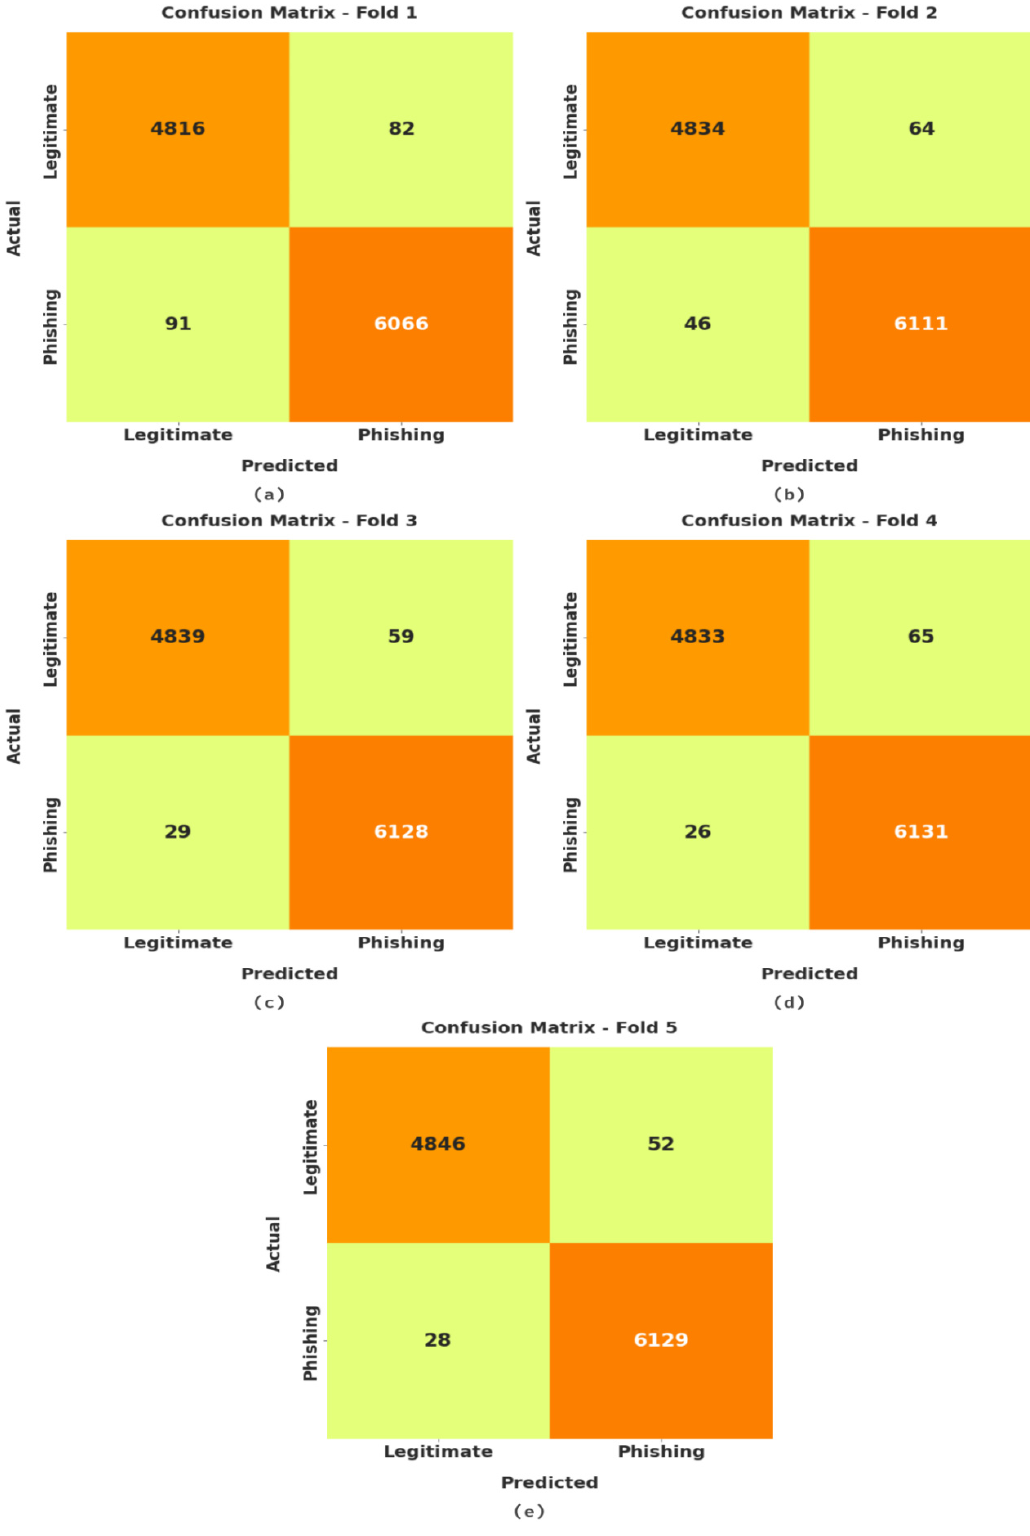
Figure 3. Confusion matrices of ODAE ‐ WPDC approach: ( a ) Fold ‐ 1, ( b ) Fold ‐ 2, ( c ) Fold ‐ 3, ( d ) Fold ‐ 4, and ( e ) Fold ‐ 5.